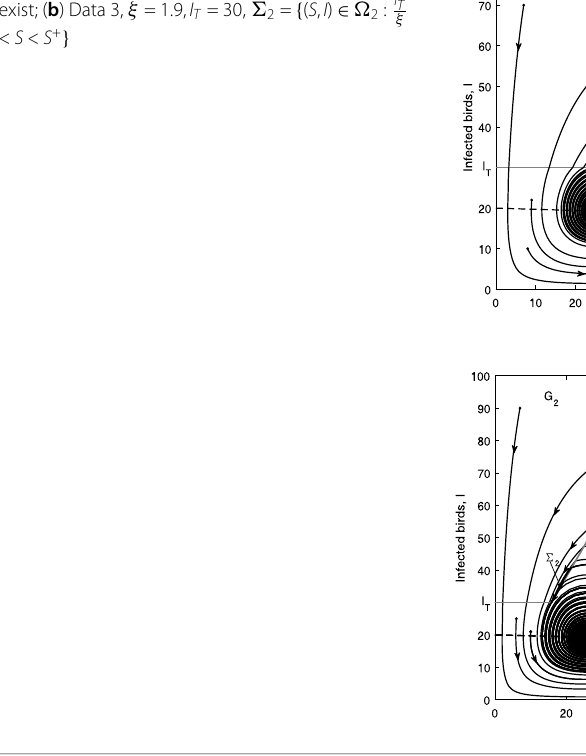
Figure 11 E R 1 is globally asymptotically stable in Case C.3: ( a ) Data 3, ξ = 1.16, I T = 30. (cid:5) 2 does not exist; ( b ) Data 3, ξ = 1.9, I T = 30, (cid:5) 2 = { ( S , I ) ∈ (cid:4) 2 : IT ξ < S < S + }